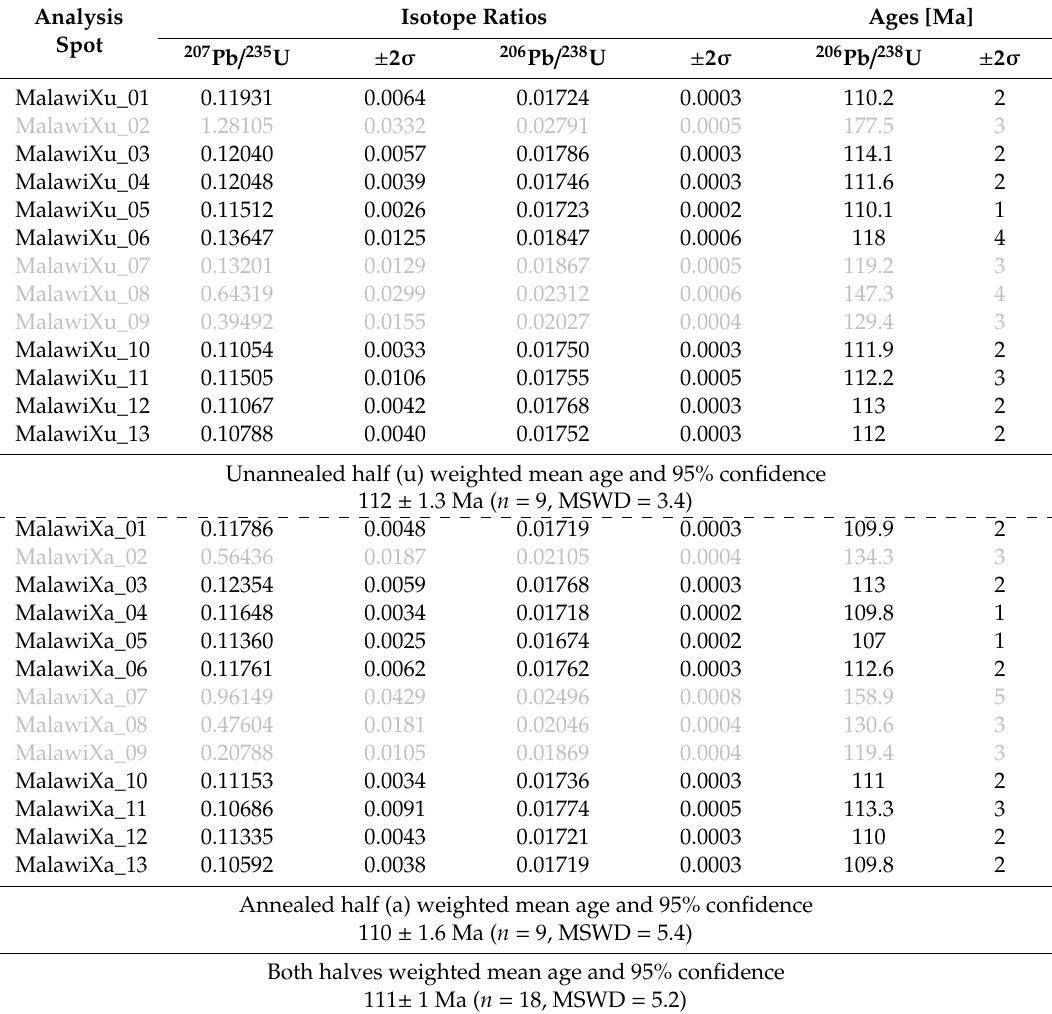
Table A5. U-Pb isotope ratios and 206 Pb / 238 U ages of the large, heterogeneous zircon crystal MalawiX from the Mt. Malosa Massif, Malawi with multiple analyses spots on both, the radiation damage-a ff ected unannealed half (u) and the heat-treated, annealed half (a).